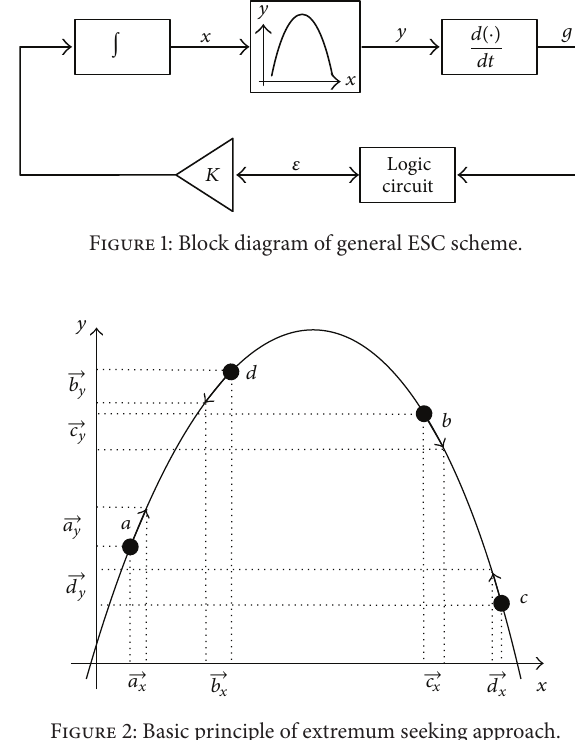
Figure 2: Basic principle of extremum seeking